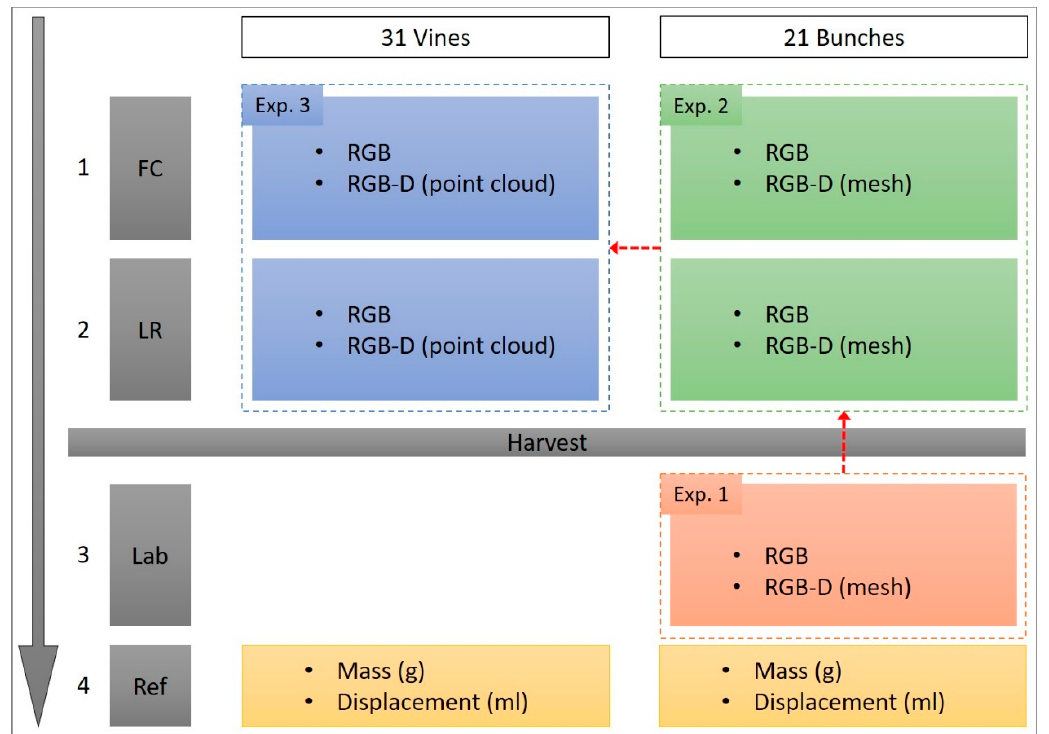
Figure 1. Location of the Shiraz vineyard in Stellenbosch, South Africa. Inset map (red rectangle) shows the three rows used for data collection.